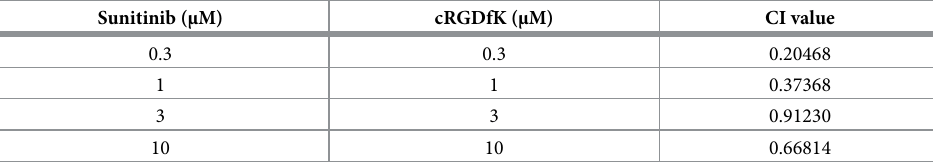
Table 1. Combination Index (CI) values for the two-drug combination against A549 cell